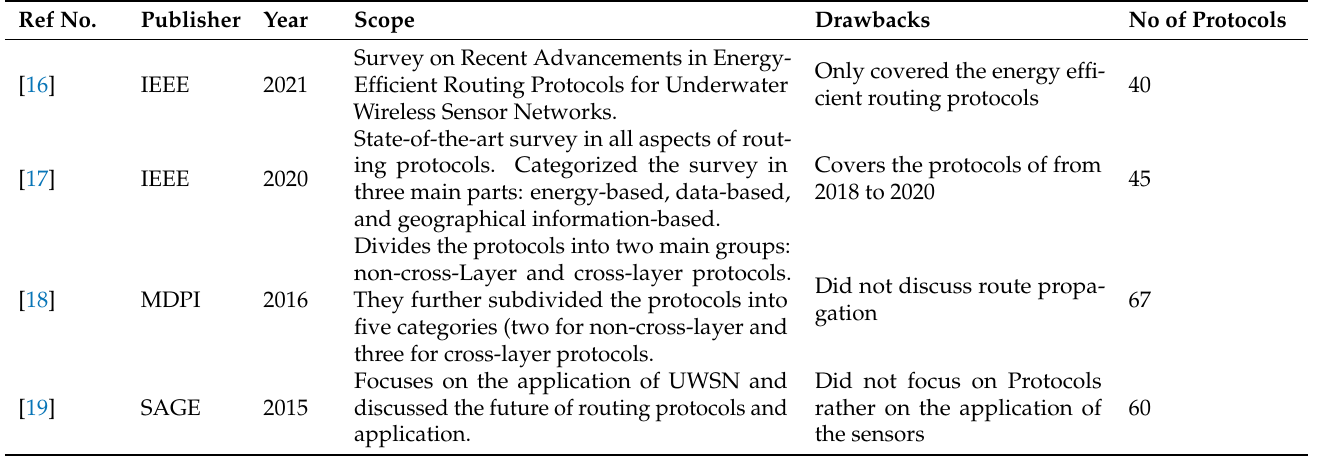
Table 1. Analysis of the existing surveys and our